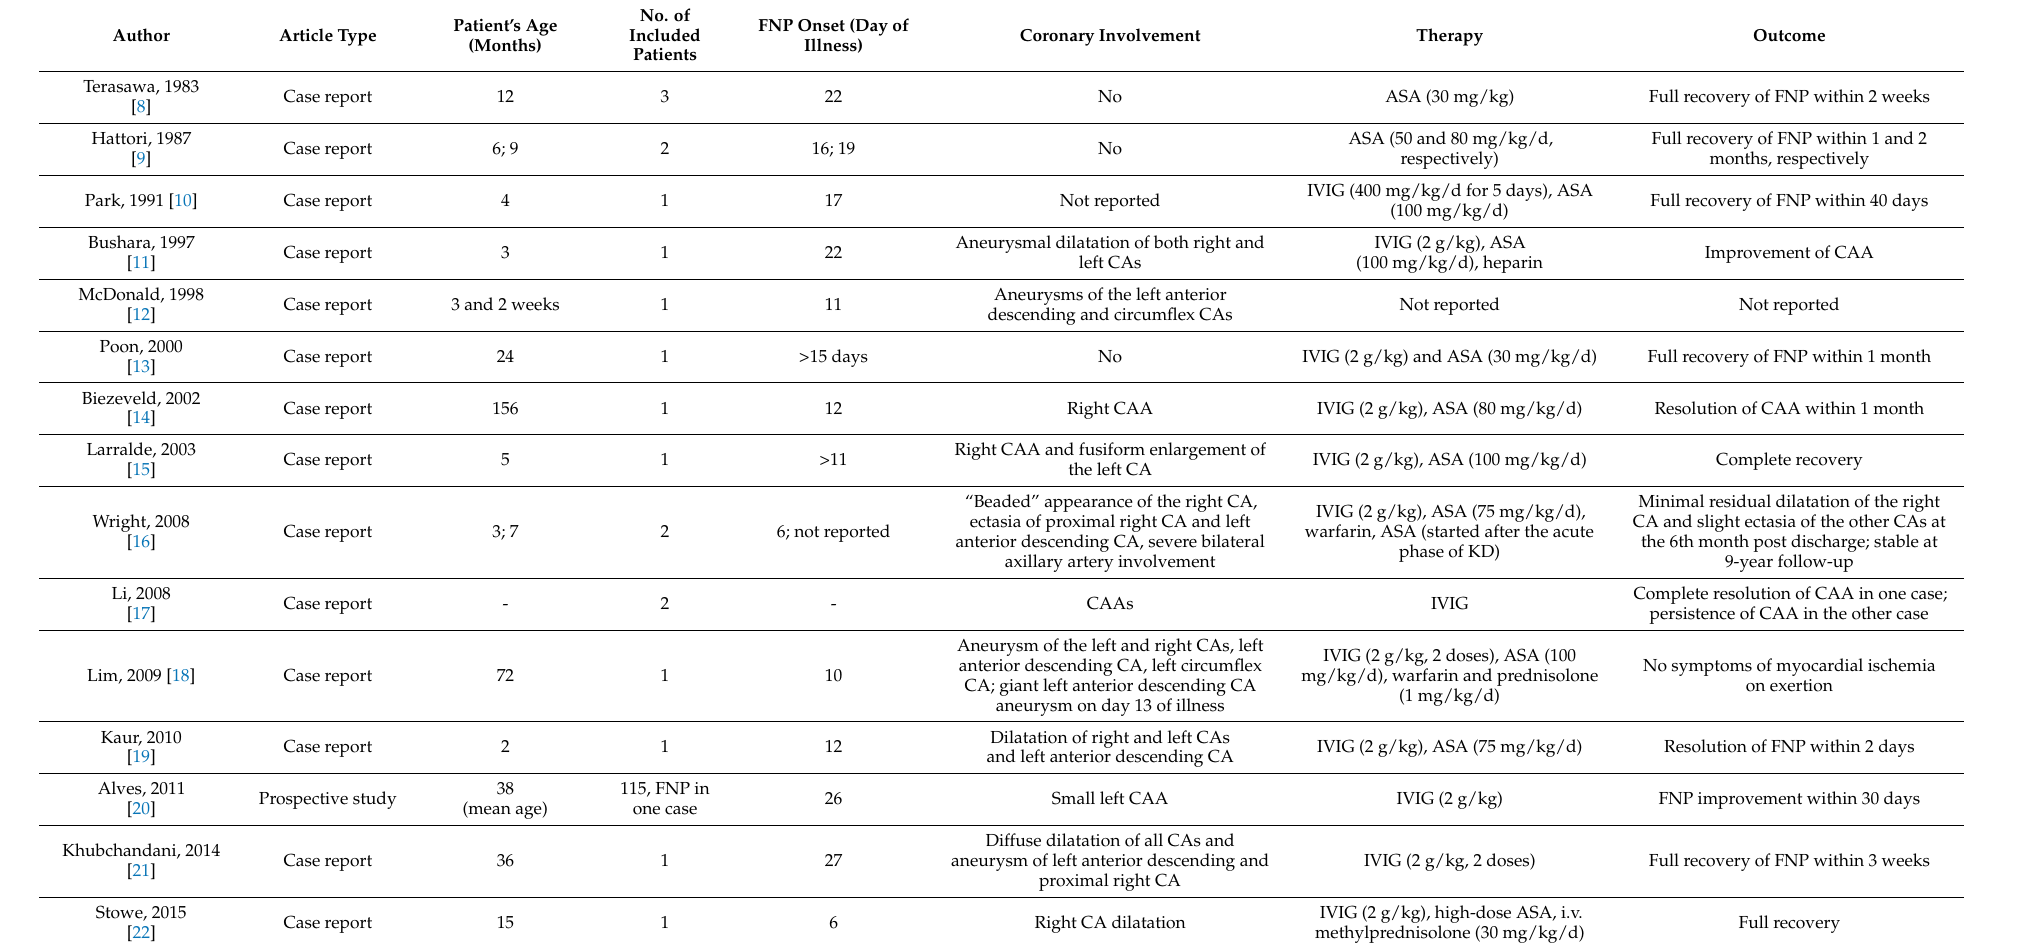
Table 3. Published articles including children with KD and concomitant facial nerve